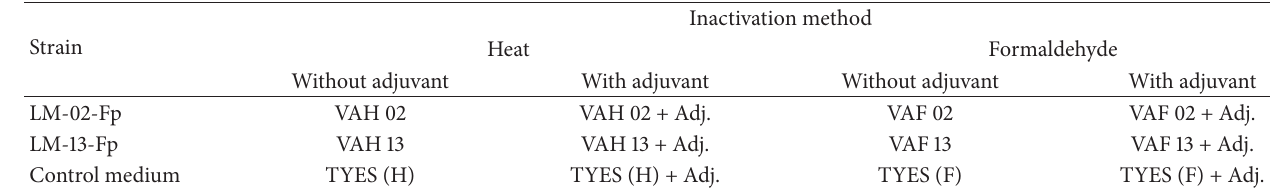
Table 1: Vaccine